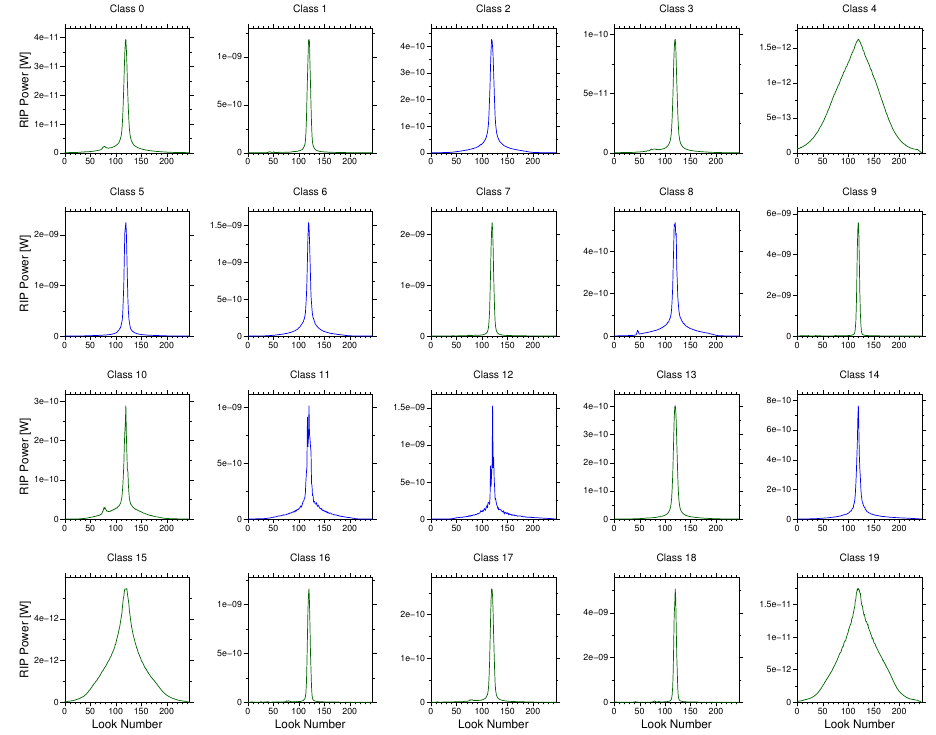
Figure A4. Middle region mean RIPs. Water classes: 2, 5, 6, 8, 11, 12,